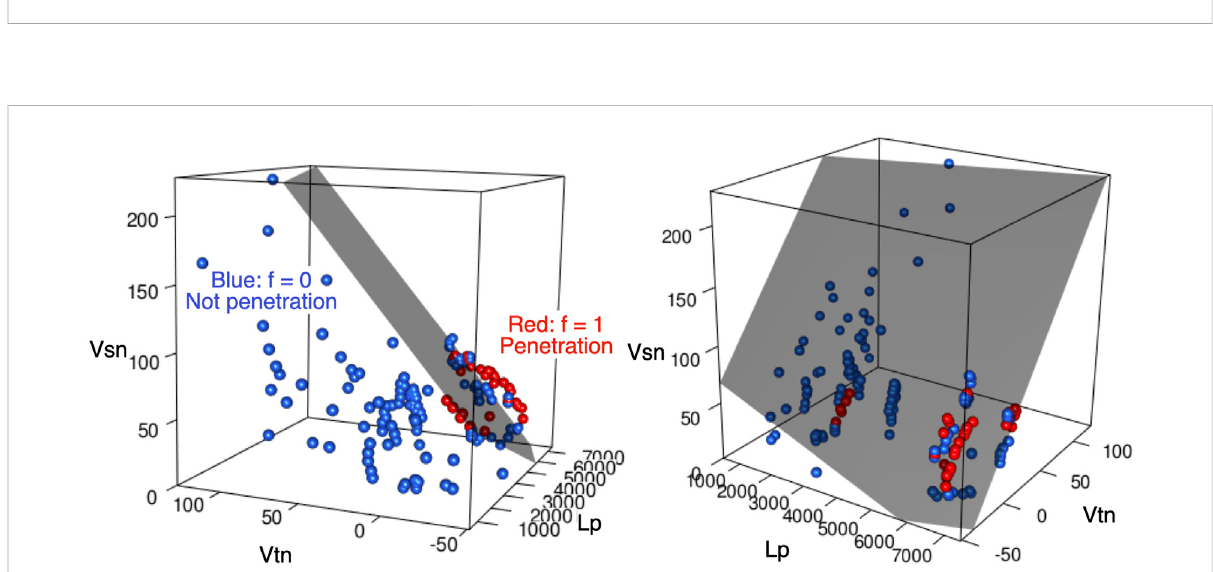
FIGURE 4 Two views of a three-dimensional plot of L p (km), v sn (mm/yr), and v tn (mm/yr) for all of the training data. Blue and red spheres indicate those labeled as f = 0 (stagnation) and f = 1 (penetration), respectively. The gray plane indicates the estimated discriminant plane that minimizes BIC (i.e., z BIC = 0 in Eq. 12, p BIC > 0.5 above the plane, and p BIC < 0.5 below the